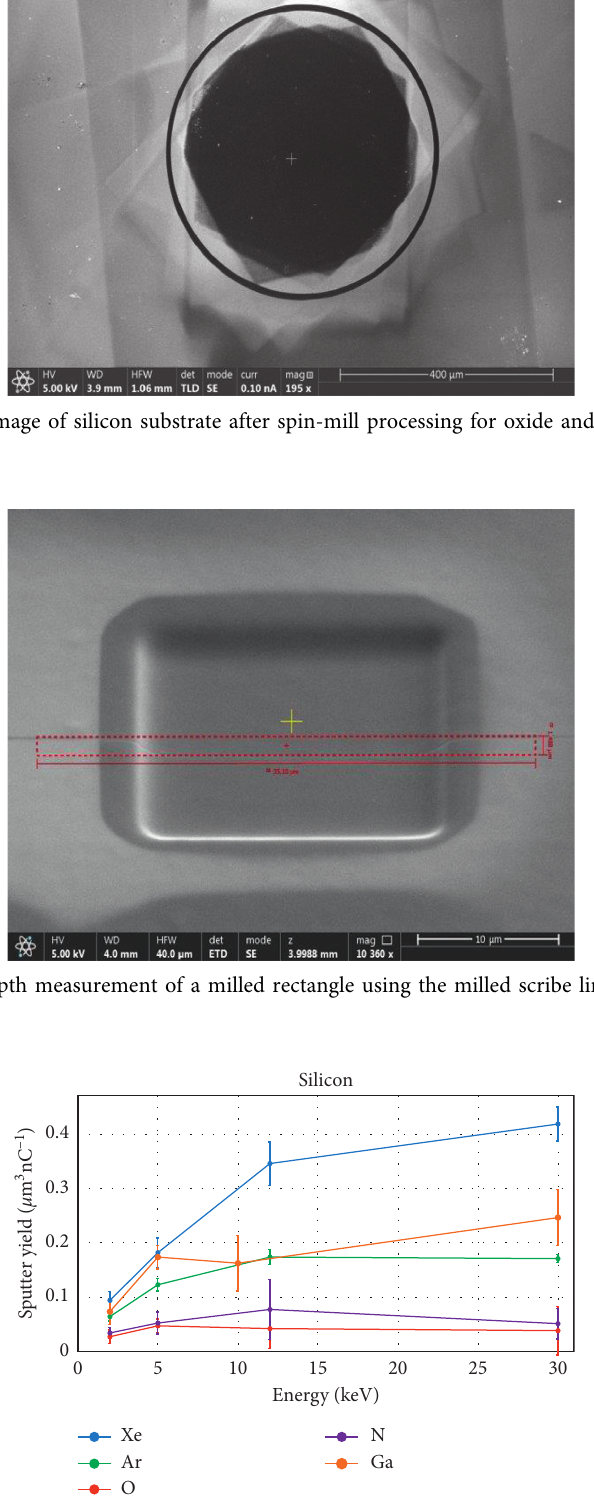
Figure 3: Sputter yield of silicon milled with different ion species at varying energies.